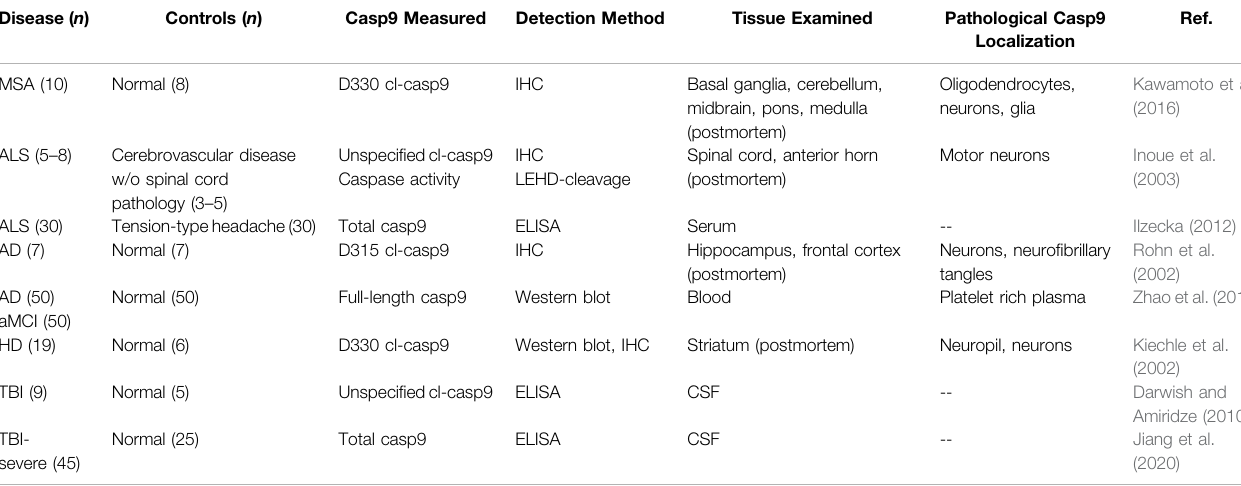
TABLE 2 | Studies reporting increased level of caspase-9 in neurodegenerative pathologies. Disease ( n